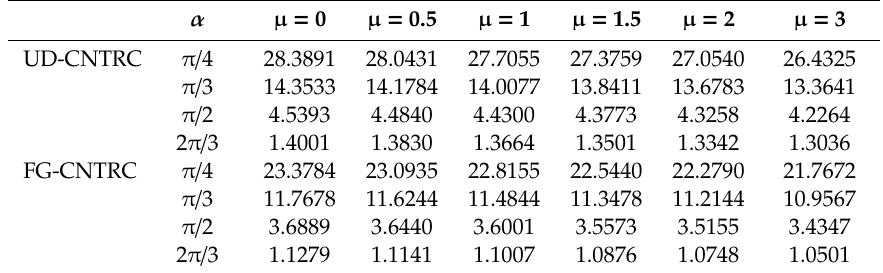
Table 9. E ff ect of the opening angle α on the nondimensional critical buckling load for S-S CNTRC = 0.14. curved beams with L / h = 10, V ∗ CNT